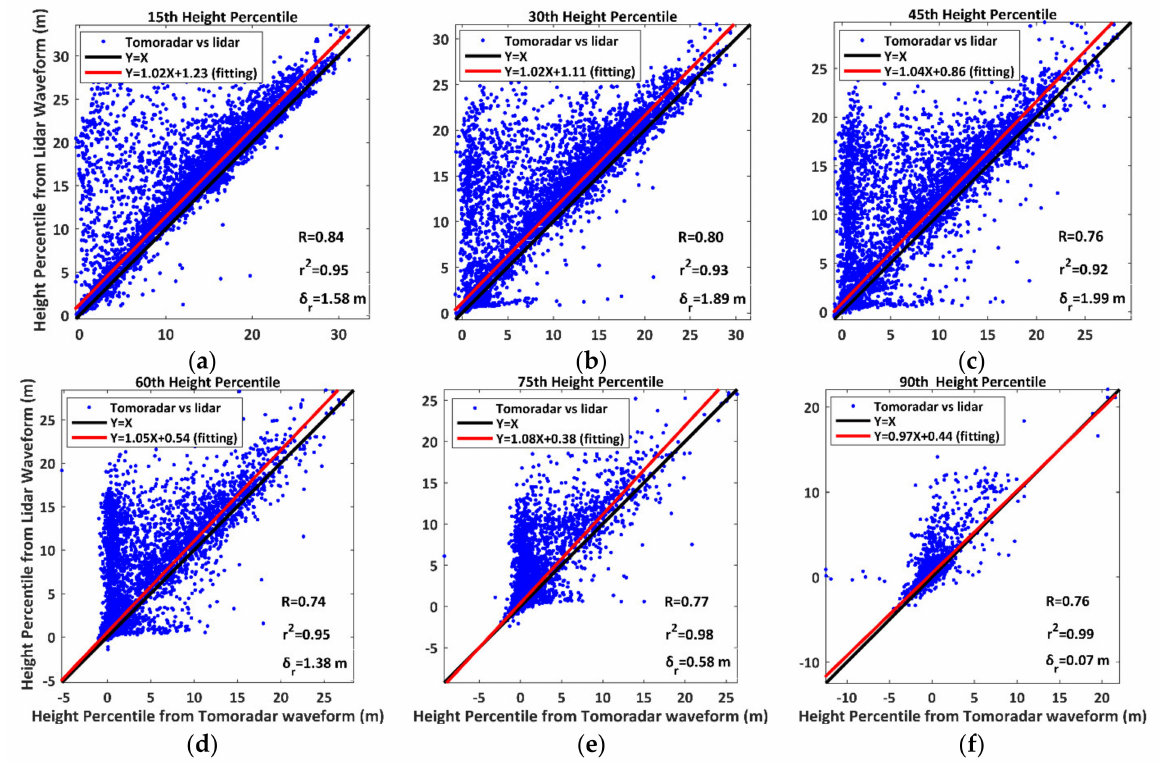
Figure 6. The scatterplots and linear regression results of height percentiles derived from Tomoradar waveforms (HP t ) and satellite lidar waveforms (HP l ). The symbol R represents the correlation coefficient between HP t and HP l . ( a ) 15th; ( b ) 30th; ( c ) 45th; ( d ) 60th; ( e ) 75th; ( f ) 90th.